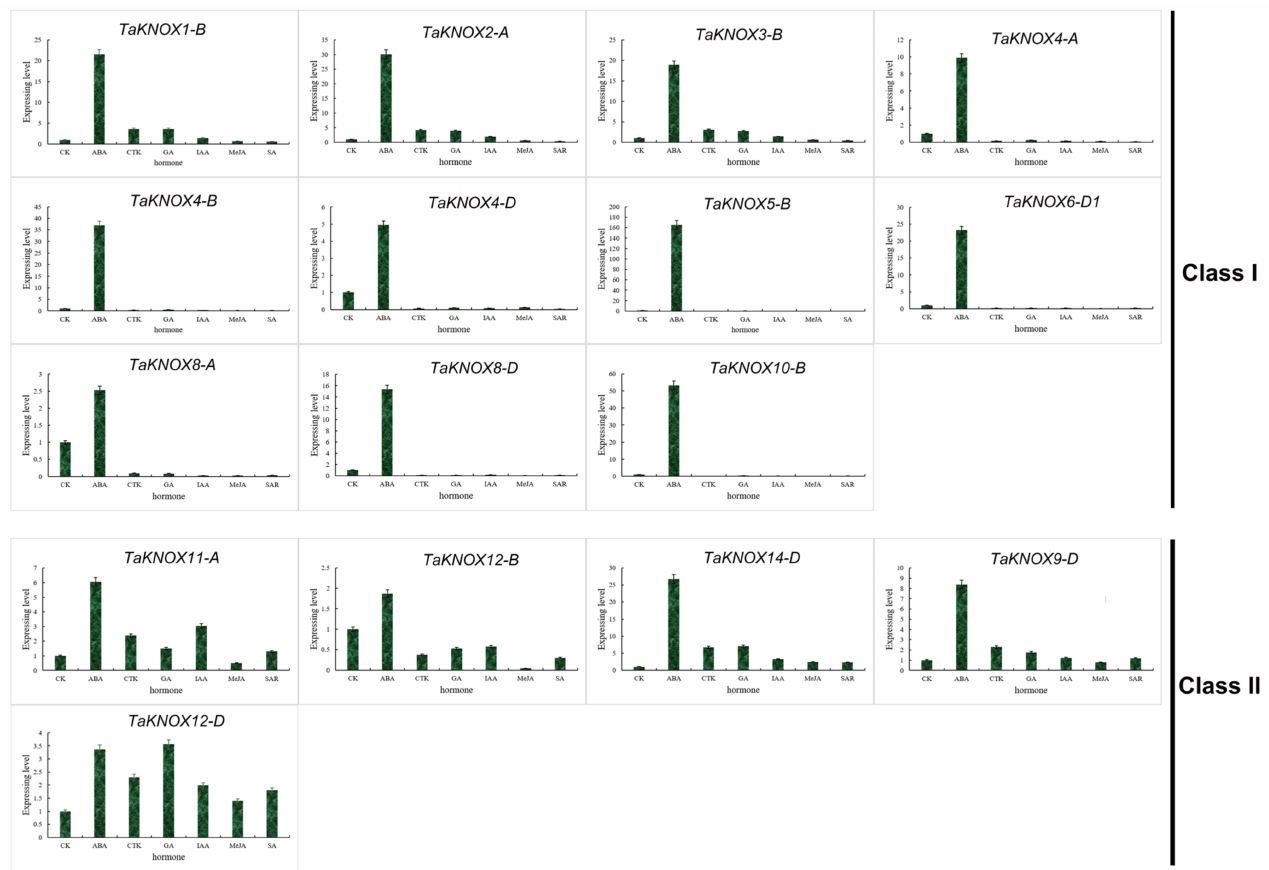
Figure 6. Expression patterns of 16 TaKNOX genes under hormone treatment obtained by qRT-PCR. The actin gene is used as an internal control. The data shown are means ± SD obtained from three biological replicates. ABA: abscisic acid, CTK: cytokinin, GA: gibberellin, IAA: auxin, MeJA: jasmonic acid methyl ester, SA: salicylic acid. Class I and class II represented different expression